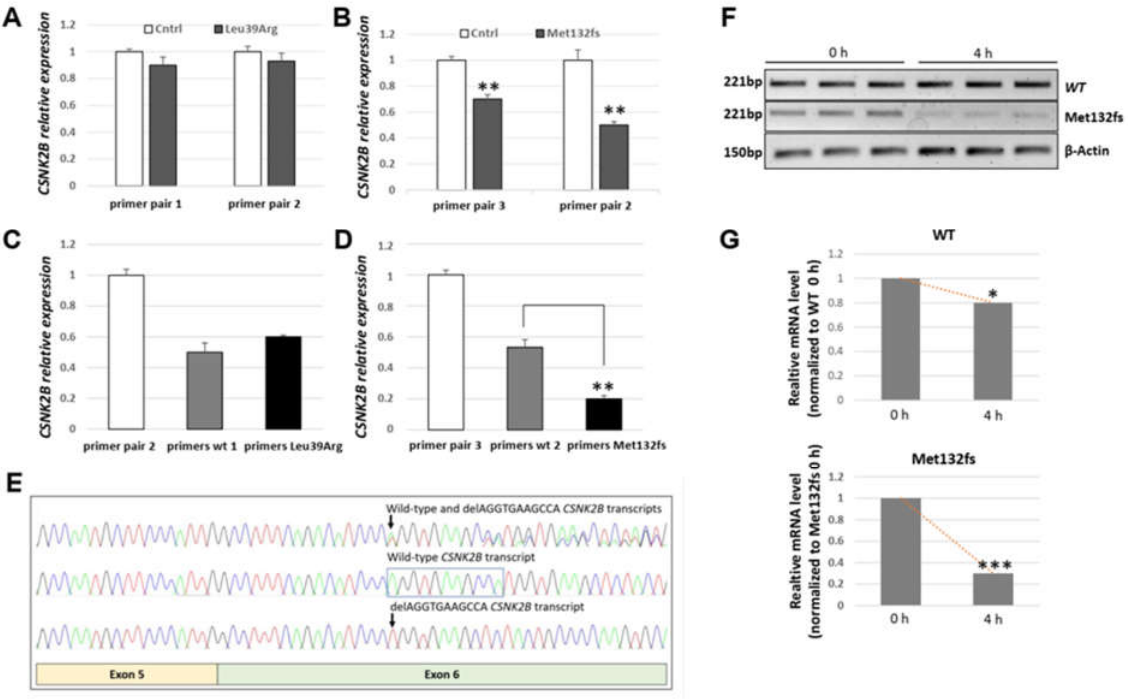
Figure 6. CSNK2B frameshift mutation reduces its mRNA stability. Quantification of CSNK2B transcript by qRT-PCR was performed using RNA extracted from peripheral blood of control (Cntrl) and patients (1 and 2) using primers for CSNK2B (pairs 1, 2 and 3) and transcript-specific oligonucleotides able to amplify either wild-type (primers wt 1, wt 2) or mutant CSNK2B mRNA (primers Leu39Arg and Met132fs). ( A ) Histogram showing no differences in the expression of total CSNK2B mRNA in patient 1 (NM_001320.7: c.116T>G, p.Leu39Arg) as compared to control. ( B ) Histogram showing a re- duction of about 50% in total CSNK2B mRNA in patient 2 (NM_001320.7: c.384_394del11, p.Met132fs) compared to control. Each bar represents the mean ± SD of three independent experiments. ** p <